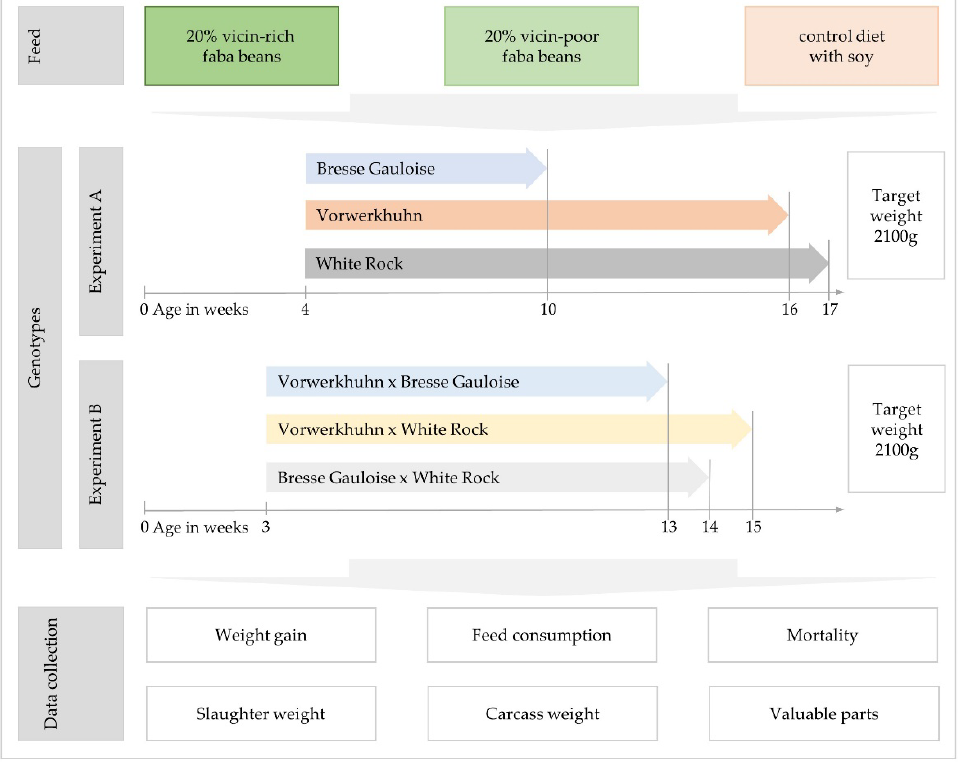
Figure 1. Schematic representation of the feeding treatments, genotypes, fattening period and collected data.